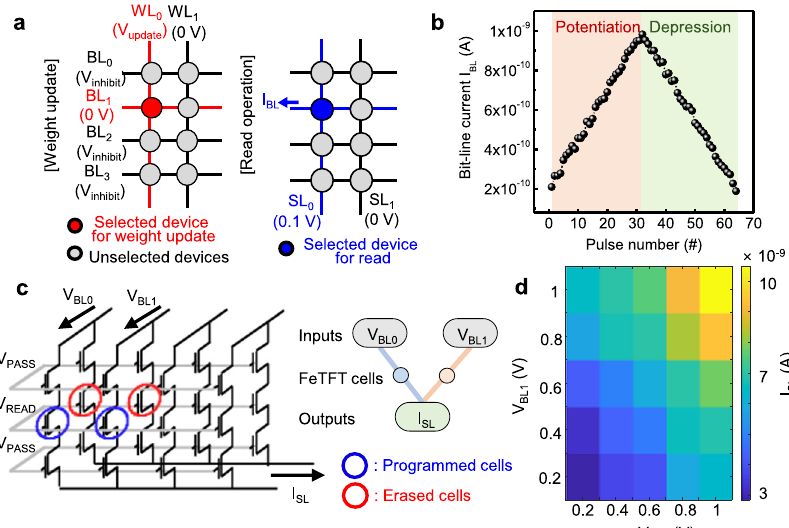
Fig. 3 | Demonstration of vector-matrix multiplication (VMM) using 3D FeNAND. a Weight update and read operation method for 3D FeNAND cell. For potentiation and depression operations, voltage pulses with incremental ampli- tudeswereappliedtotheselectedWL,andtheselectedBLwassetto0V.Program- inhibit pulses with incremental amplitudes were applied to unselected BLs. The conductanceofthedeviceswascon fi rmedbymeasuringthecurrentoftheselected BL. b Potentiation and depression characteristics of 3D FeNAND cell. c Equivalent